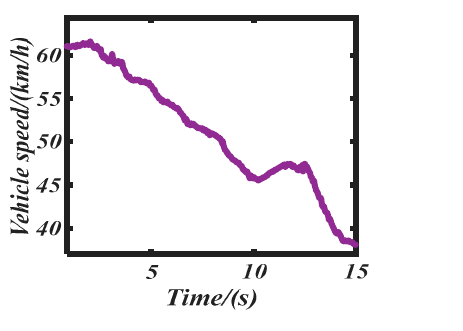
Figure 7. Steering angle.